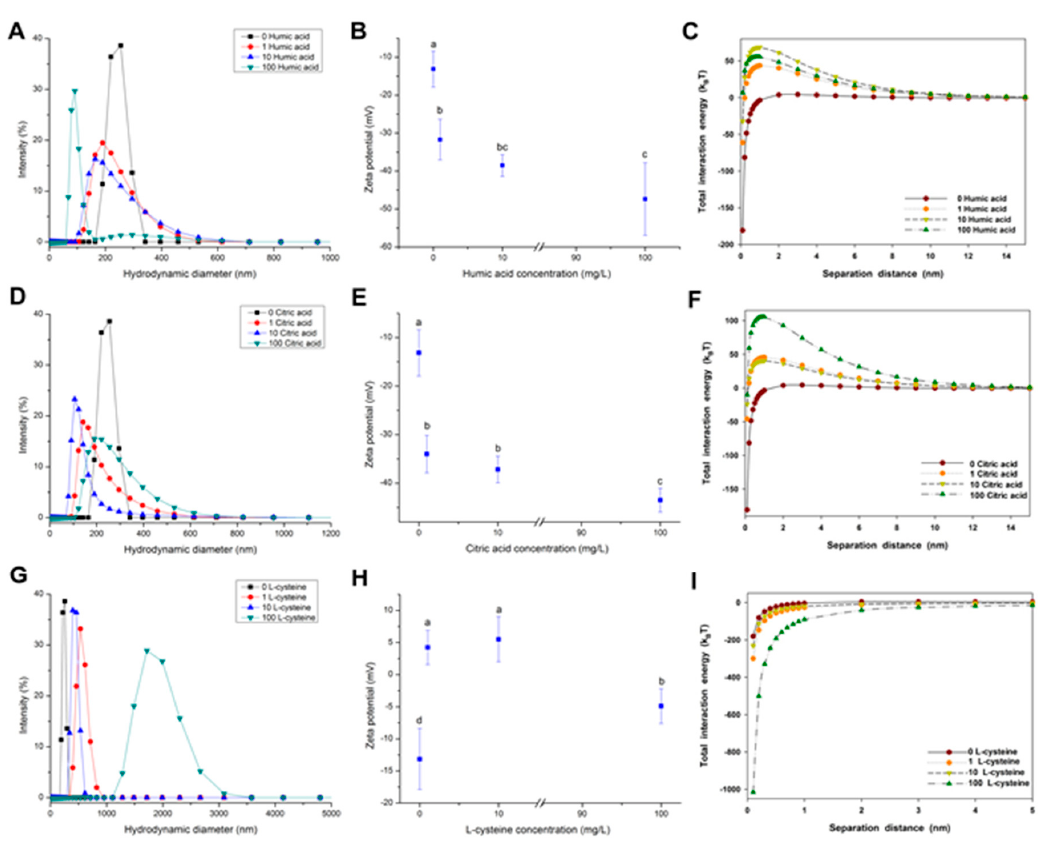
Figure 3. Size distribution ( A , D , G ); zeta potential ( B , E , H ); and calculated DLVO total interaction energy ( C , F , I ) of CuO NPs (100 mg/L) in the aqueous solution with 1, 10, and 100 mg/L humic acid ( A – C ); citric acid ( D – F ) and L -cysteine ( G – I ) at a neutral pH with a constant ionic strength of 10 mM NaCl. The values of zeta potential were given as mean ± SD of triplicate samples. Different letters in Figure 3B,E,H indicate significant differences among the treatment means ( p <